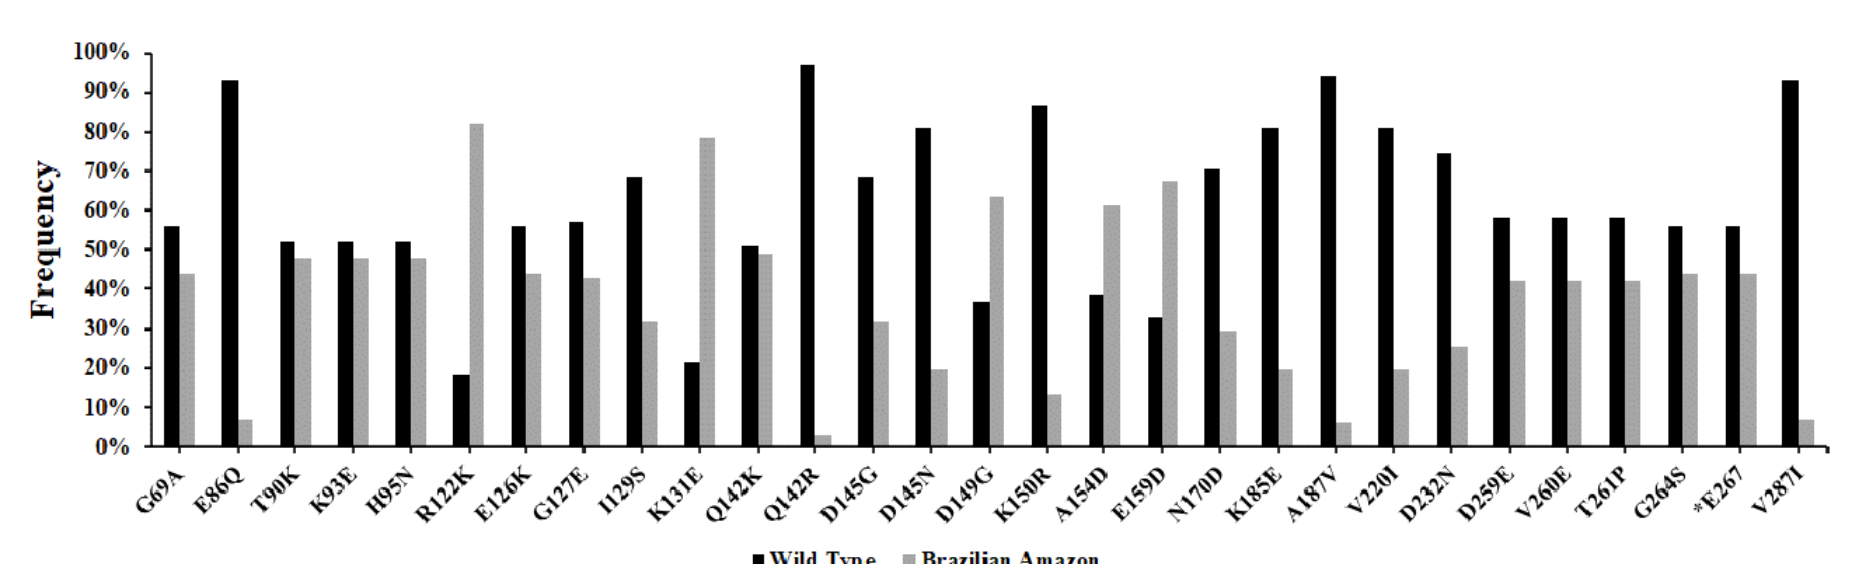
Figure 2. Frequency of substitutions in the PvCyRPA of P. vivax isolates from Brazilian Amazon. The two colors (black and gray) represent the two alleles within a population: reference allele and variant allele, respectively. The identification code represents the amino acid in the Sal-1 reference sequence (first character), followed by the position of this residue (number), and the replacing amino acid observed at the same position (last character).